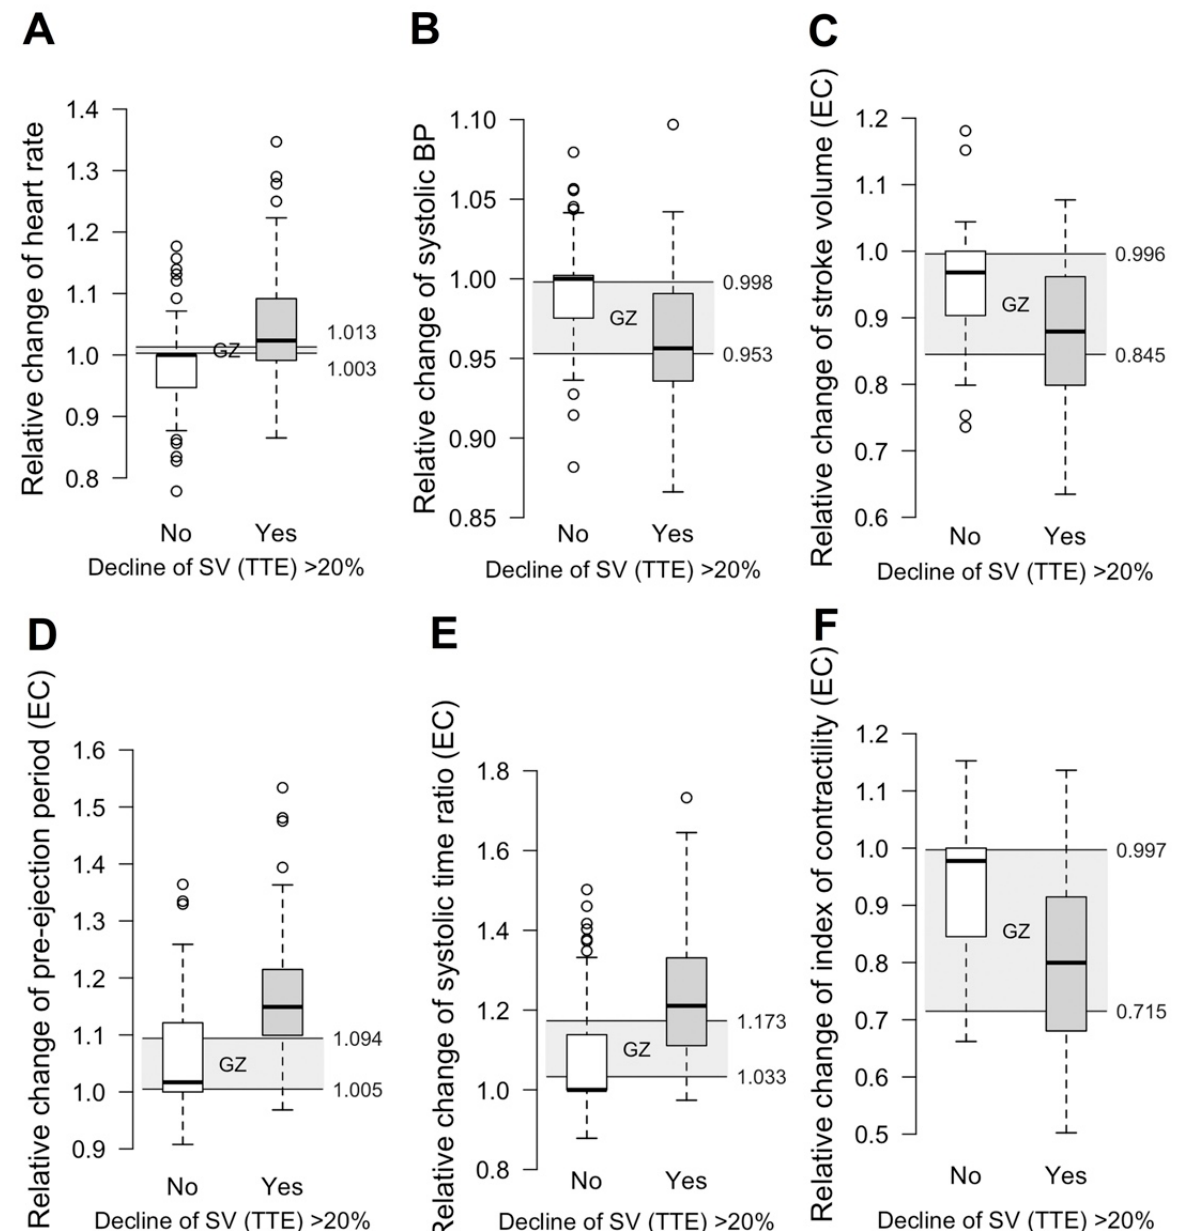
( C – F ). ROC curves are displayed in the usual fashion. The area under the curve (ROC-AUC) and its confidence intervals (CI) due to bootstrapping can be found at the bottom right of each plot. The cut-off values of the diagnostic grey zone are shown on the ROC curve. (EC): indicates values determined by electrical cardiometry; BP: blood pressure.